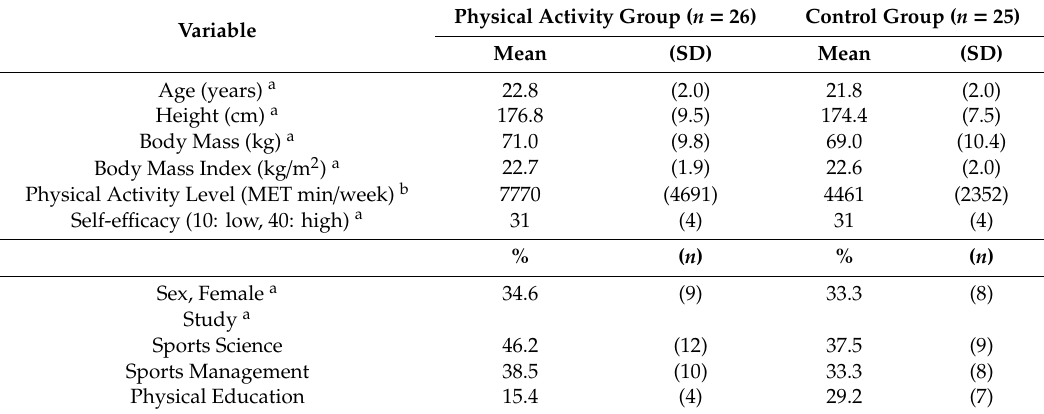
Table 1. Demographic data of the participants by group ( n =